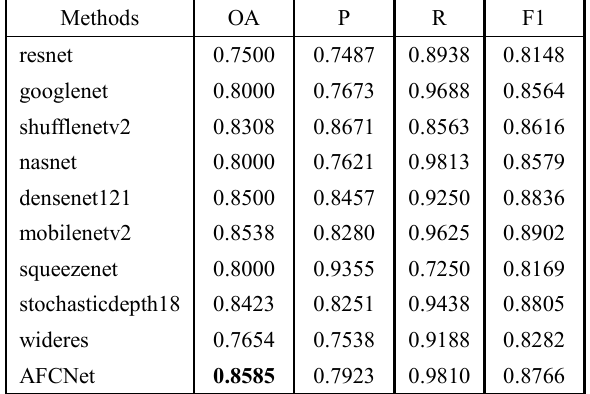
Table 2 The accuracy comparison of AFCNet and other neural network